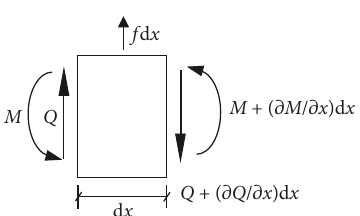
Figure 4: Microelement diagram of cantilever